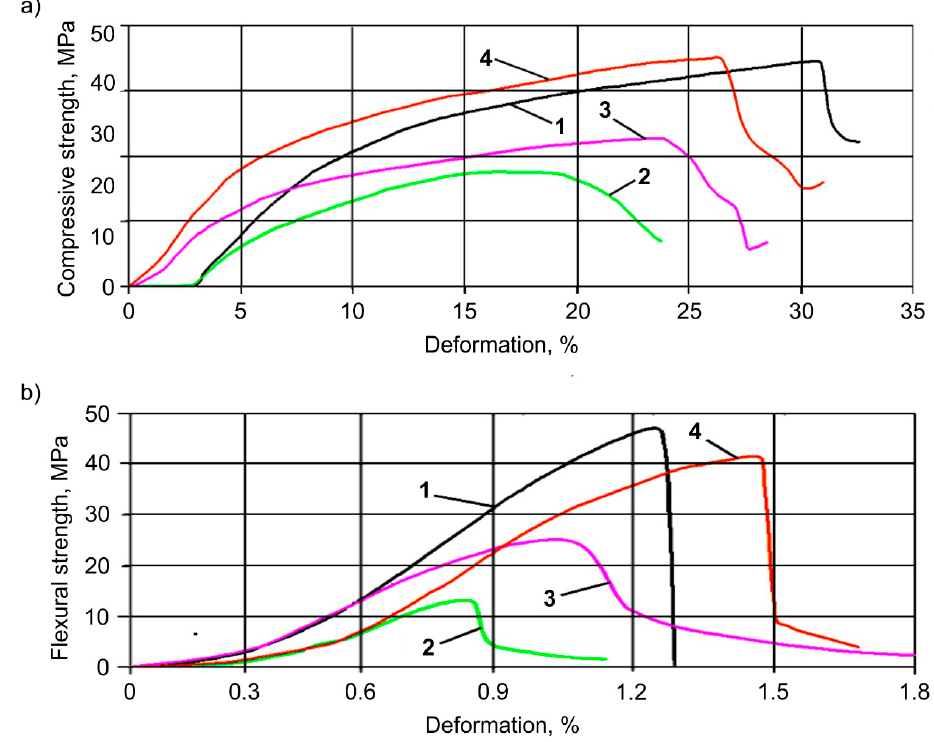
Figure 5. The stress–strain curves for MMCs containing C (1); Al 2 O 3 (2); SiC (3); and C + Al 2 O 3 + SiC mixture (4). ( a ) Compressive strength; ( b ) Flexural strength.